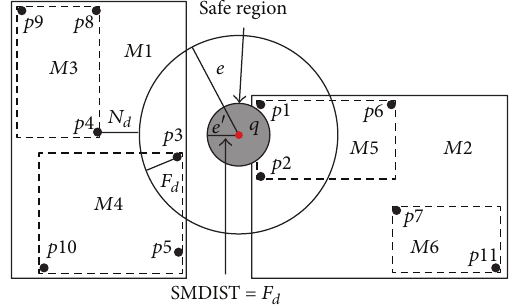
Figure 3: Basic Safe Region.